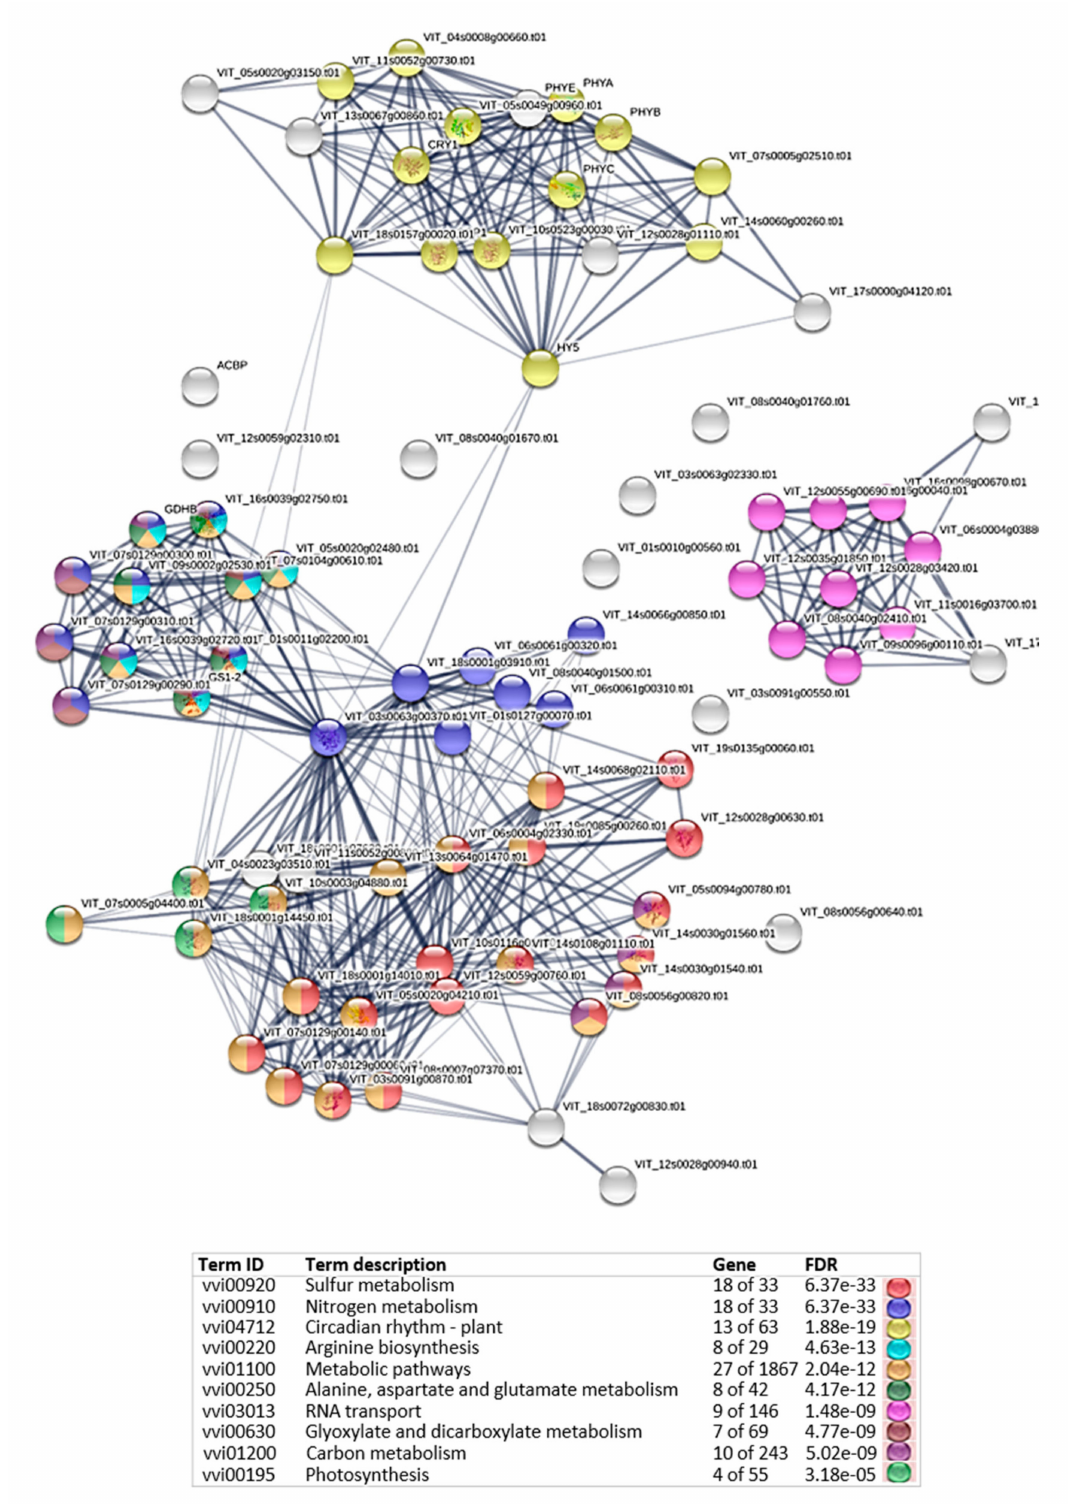
Figure 7. Protein–protein interaction network for shoot vs. leaf